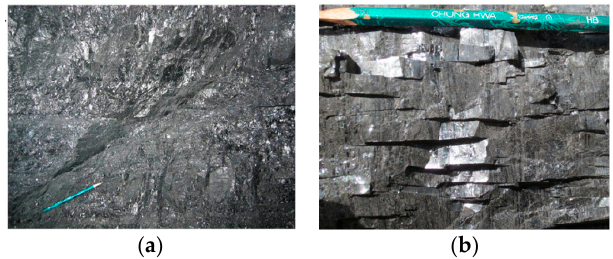
Figure 1. ( a ) Fractures, Chengzhuang Mine (Reproduced with permission from [43]); ( b ) cleats, Chengzhuang Mine (Reproduced with permission from [44]).